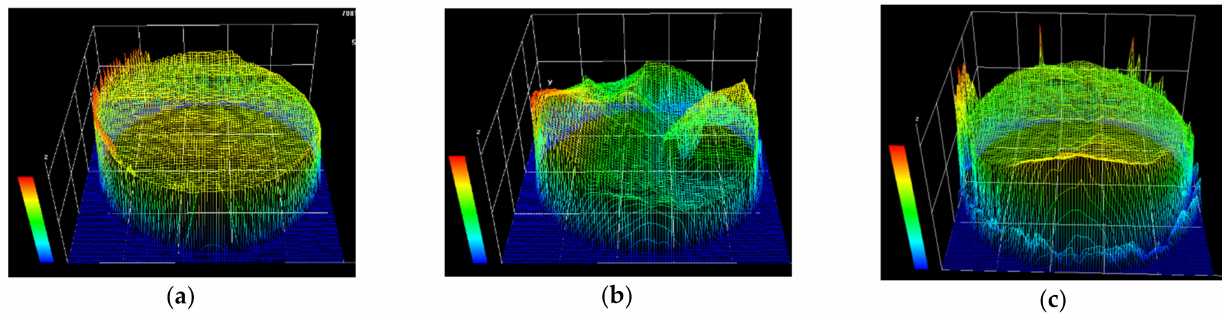
Figure 7. Stereograms of the fracture surface: ( a ) HCF fracture surface; ( b ) LCF fracture surface; ( c ) HLCF fracture